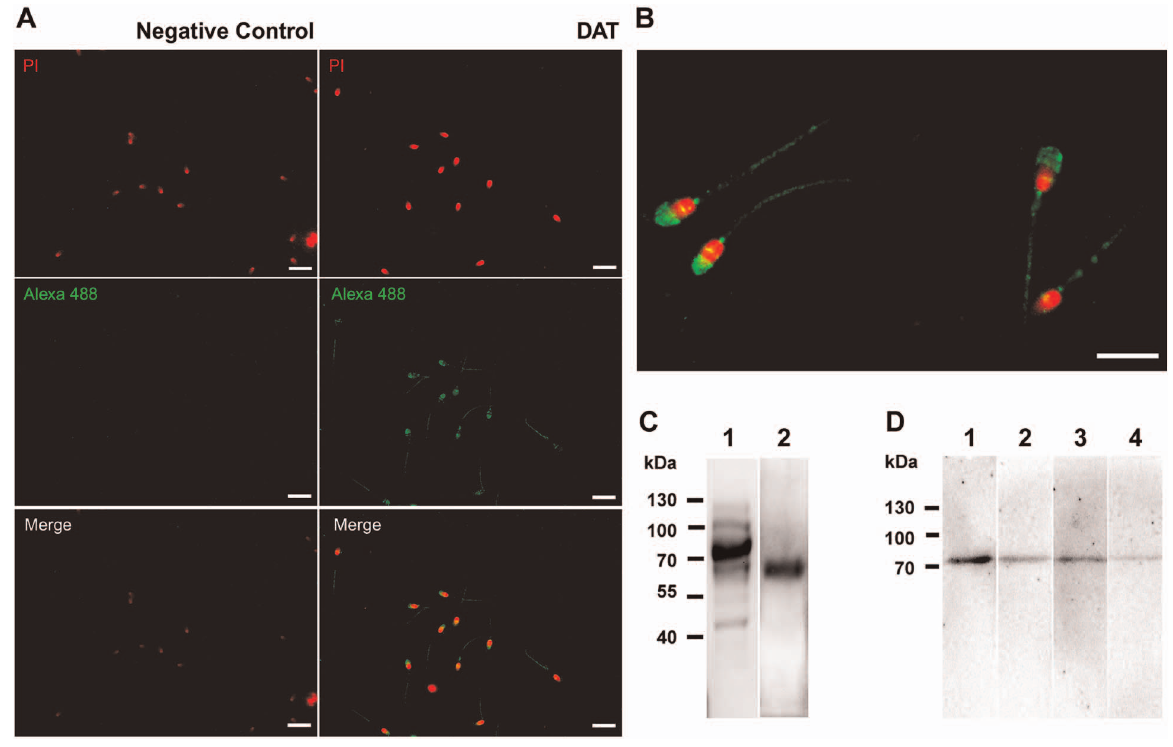
Figure 1. Dopamine transporter (DAT) is present in equine ejaculated sperm. The presence of DAT in ejaculated equine sperm was investigated with immunodetection and microscopy methods. A) Sperm were fixed and analyzed by immunofluorescence using an anti-DAT antibody or only secondary antibody as negative control. B) Magnification of DAT immunodetection in sperm. Bar scale is 10 m m. C) 80 m g of total protein extract from rat brain (line 1) and equine sperm (line 2) were analyzed with SDS-PAGE and Western blot using a specific human anti-DAT antibody. Images are representative of 3 independent experiments. D) UREA/SDS-PAGE and Western blot analysis for total protein extract (100 m g) for rat brain (line 1 and 3) and equine sperm protein extract (line 2 and 4), with (line 2 and 4) or without (Line 1 and 3) anti-Dat antibody preabsorbed by immunogenic peptide (SC-7515 P).